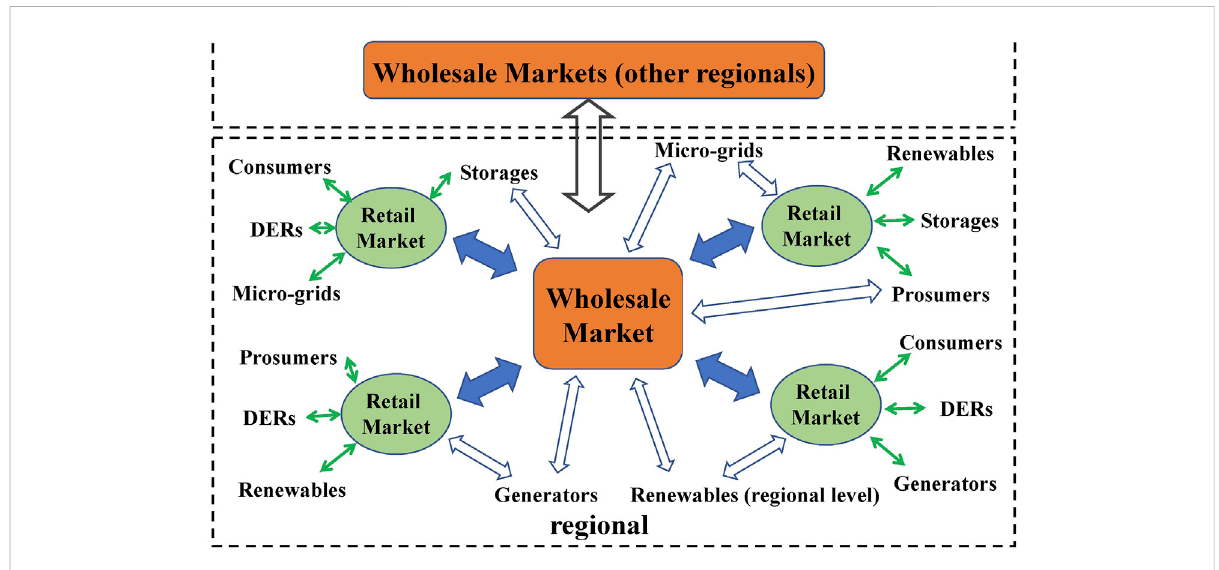
FIGURE 4 Interaction between wholesale markets and retail